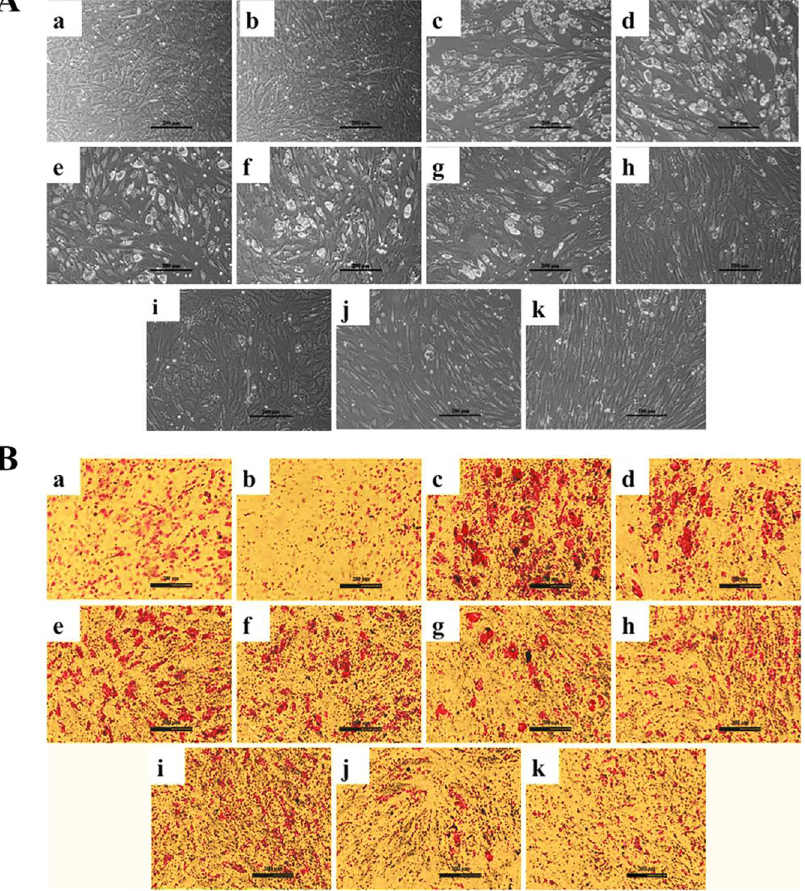
Fig 2. CPF alone prevented ability of adipogenic cocktail (DMI) towards differentiation of C 3 H 10 T ½ cells to adipocytic lineage. (A) Phase-contrast micrographs indicatedappearanceof lipid vesicles(white) in (c) DMI and (d) DMI+ DMSO comparedto (a) CT and (b) DMSO. Increasingconcentrations of CPF (0.01, 0.1, 1, 10, 25, 50 and 100 μ M) caused a gradualdecreasein lipid vesicle accumulationof DMI-treated cells (e-k). (B) Oil Red O stainedcells followingadipogenic cocktail (DMI) treatment to C 3 H 10 T ½ cells w.r.t CT and DMSO. CPF in a dose-dependent manner decreased the adipogenicdifferentiation(a-k, similar to above phase-contrast images). Scale- 200 μ